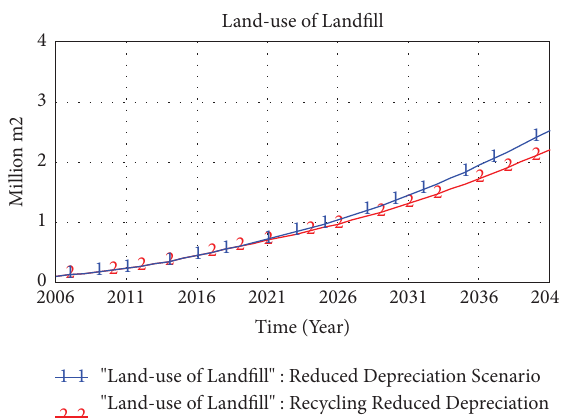
Figure 14: Te trend of land use of landflls in the depreciation reduction scenario for both options.